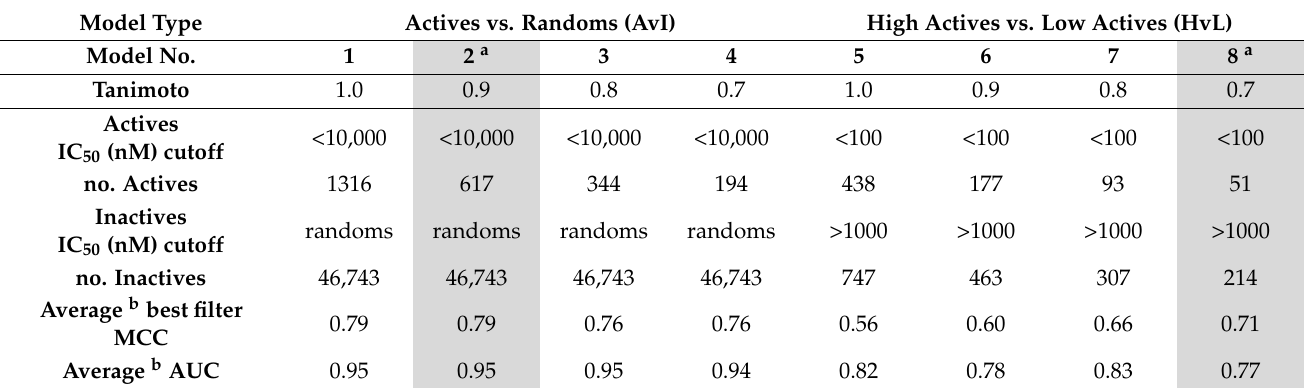
Table 1. Comparison of BACE-1 ISE models’ properties and